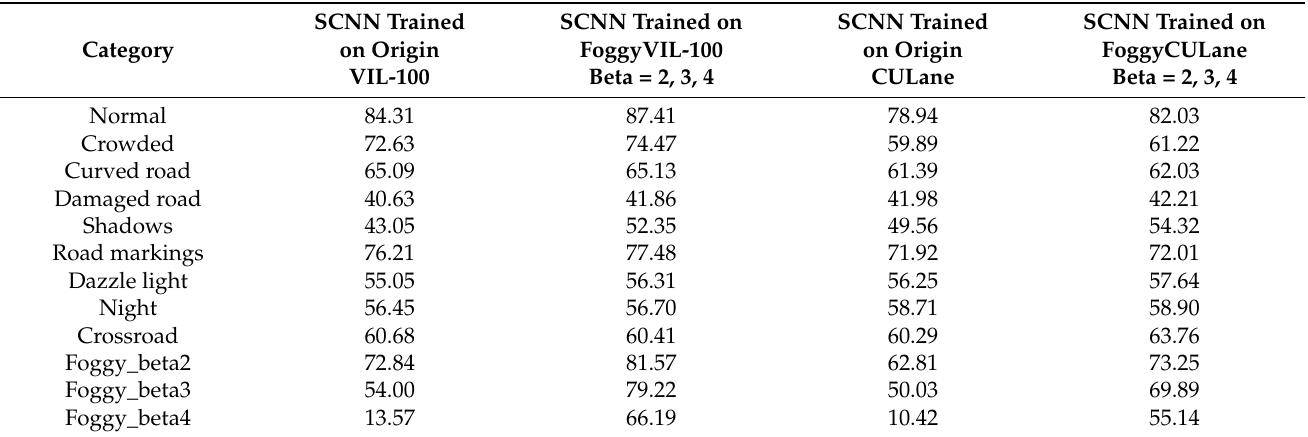
Table 9. Lane detection results (F1-measure) of SCNN tested on different scenes of the FoggyVIL-100 test set, with the model trained with different